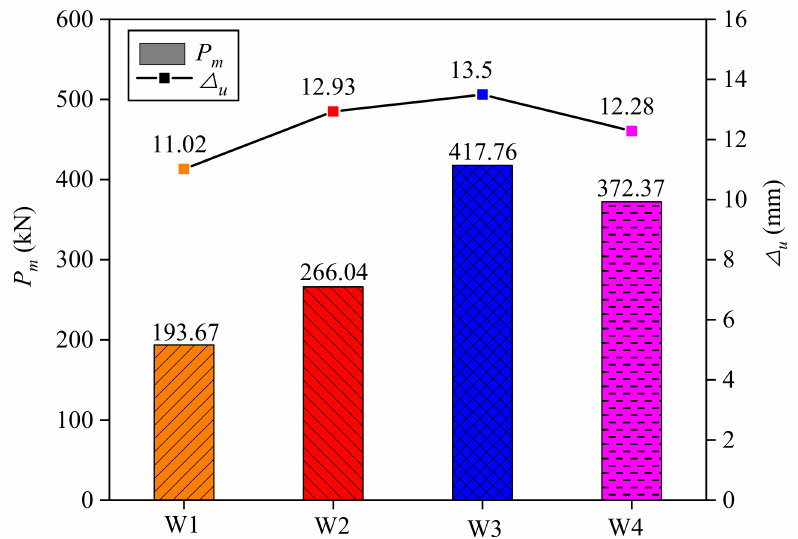
Figure 10. Bearing capacity and ultimate